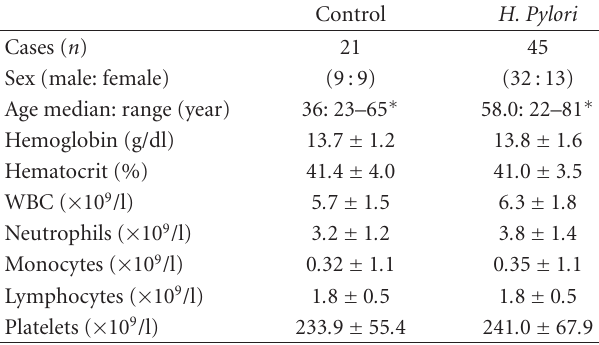
Table 1: Characteristics of participants in this